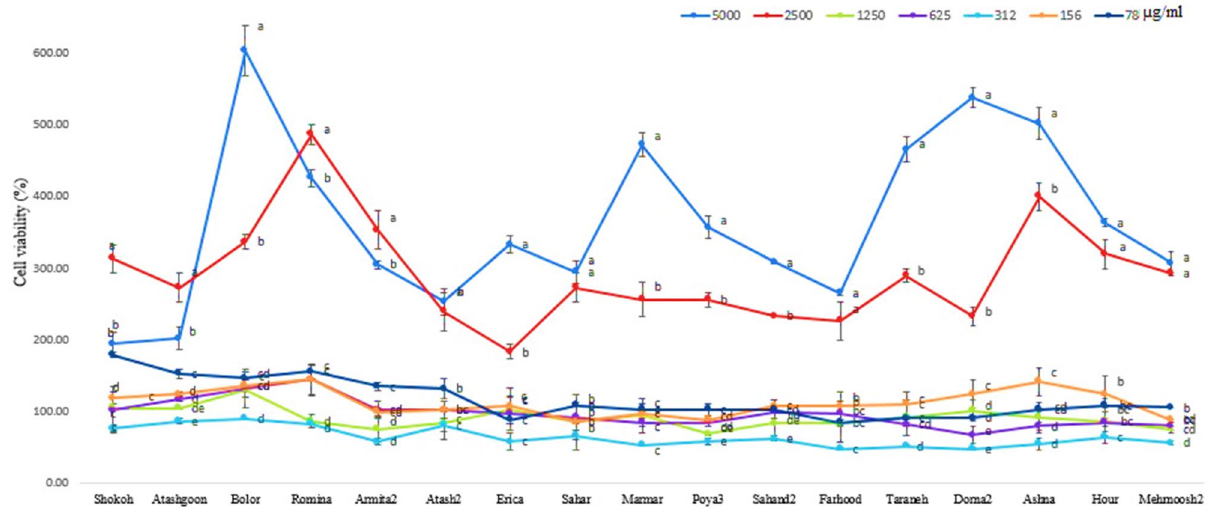
Figure 1. In vitro anticancer activity of the C. morifolium extracts against MCF-7 cell lines (Data are presented as normalized mean values of cell viabilities ± SD (n =